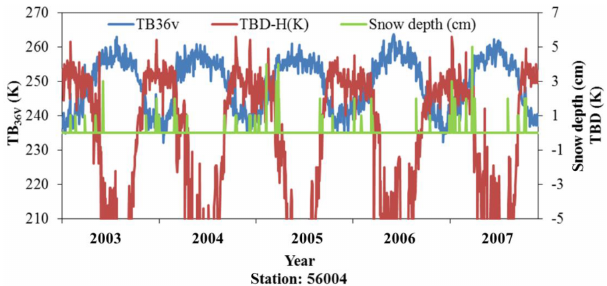
Figure 7. Temporal variation of brightness temperature at 36GHz for vertical polarization (TB 36V ) , TBD and snow depth observed at Tuotuohe station (ID: